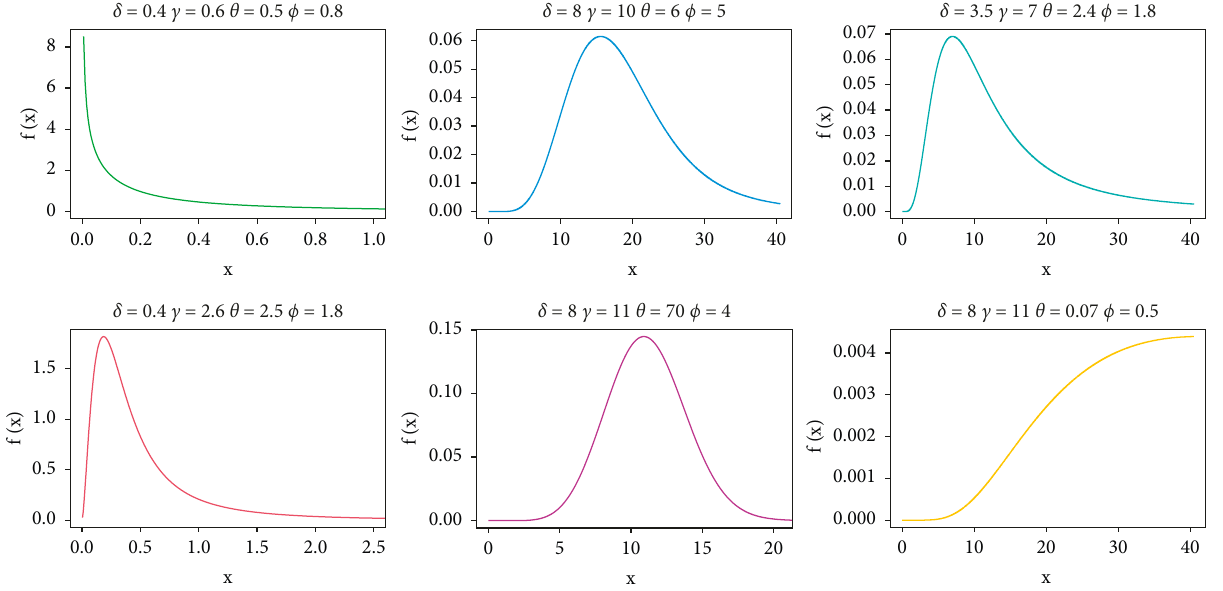
Figure 1: The pdf plots of the IELoP distribution.